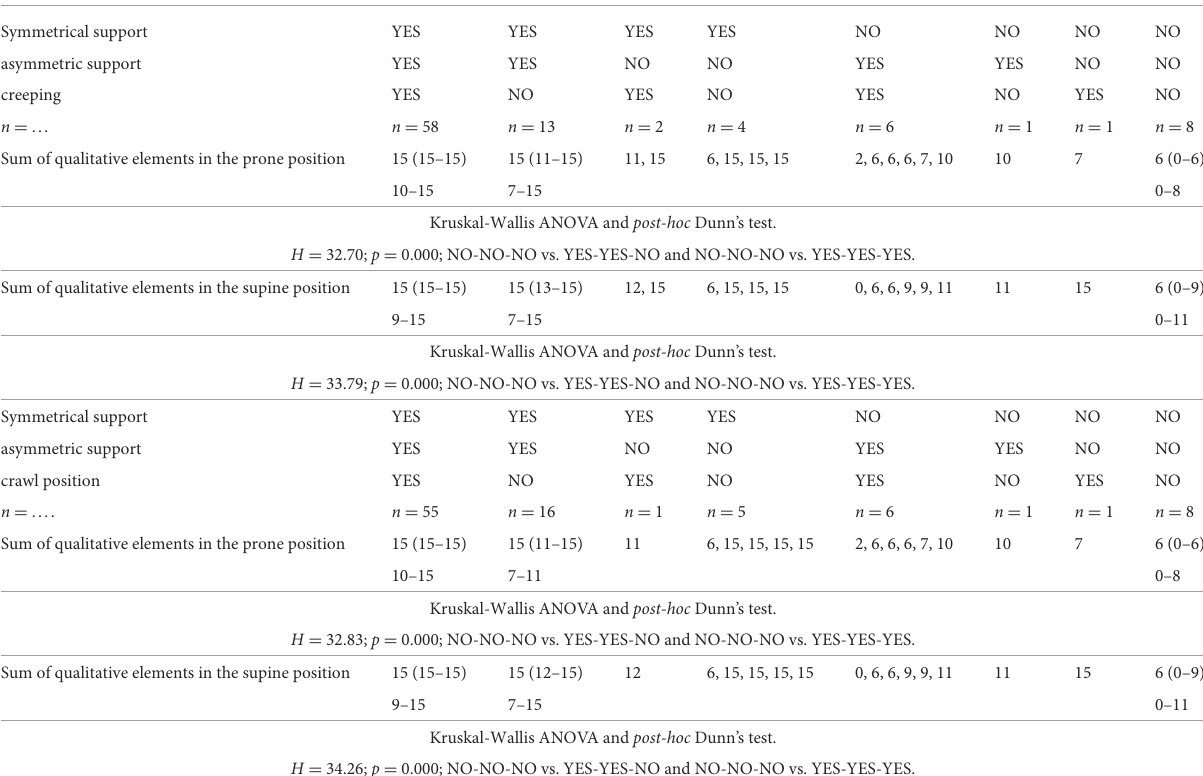
TABLE 2 The motor development in the prone position: symmetrical support asymmetric support creeping OR crawl position, according to the quality of motor performance assessed at the age of 3 months, in prone and supine positions.